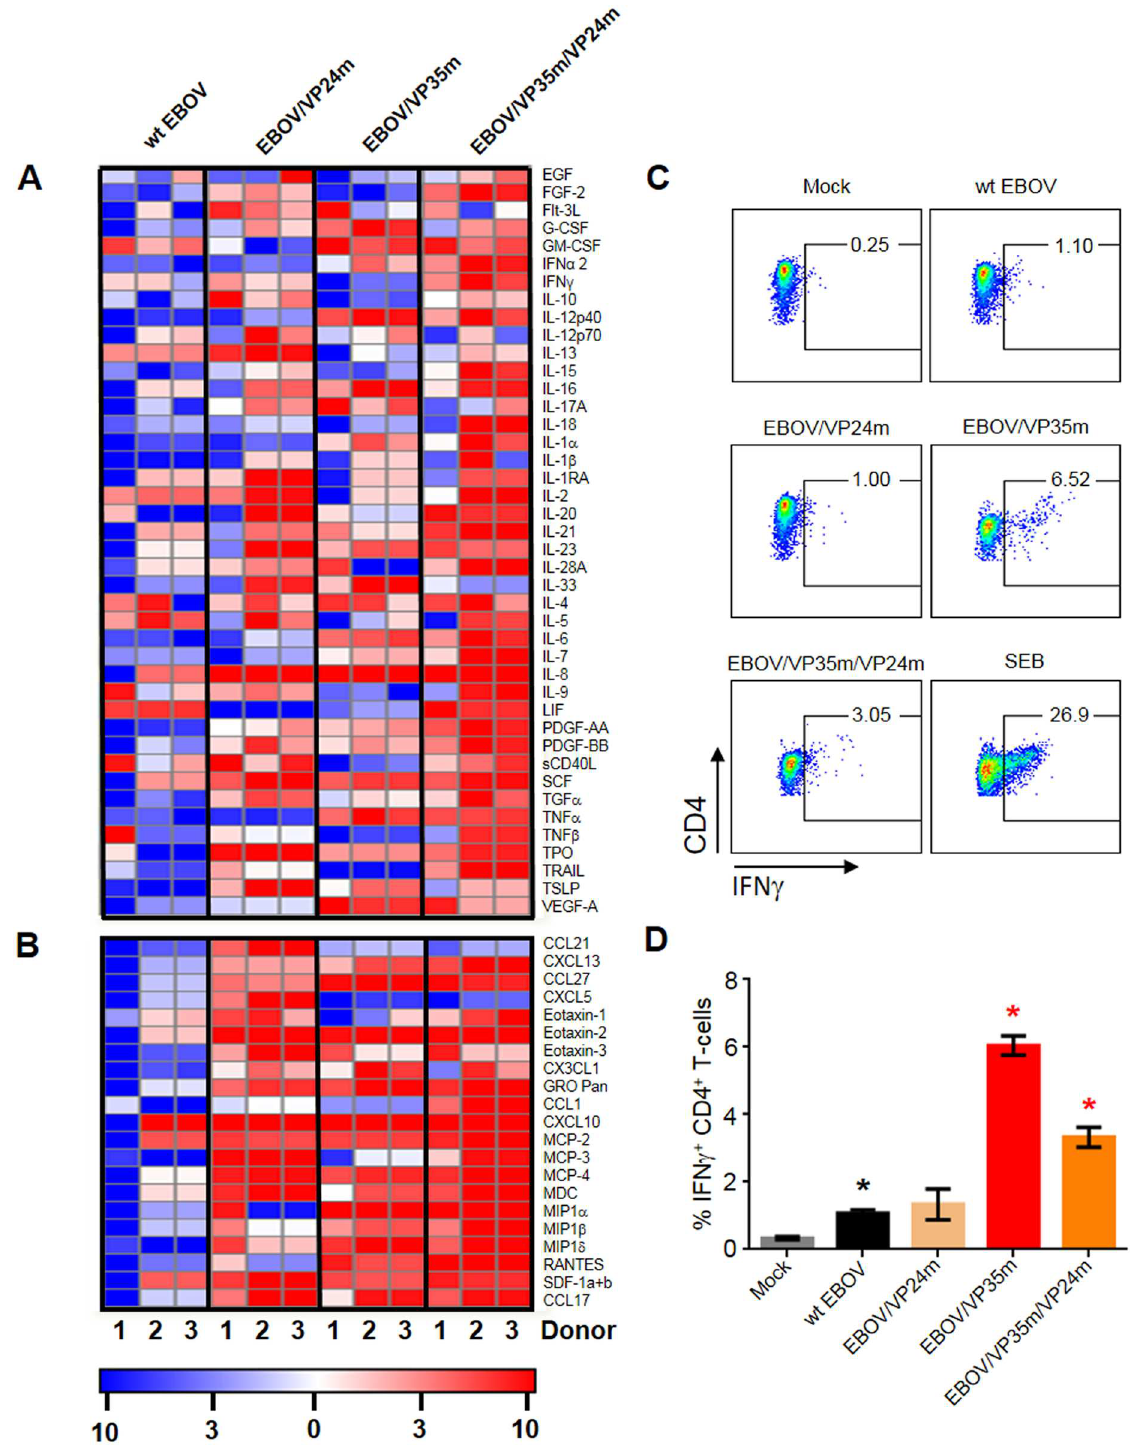
Fig 4. Disabling of IIDs changes cytokine and chemokine expressionin co-cultures of CD4 + T cells with infected DCs. A, B. CMV-pulsed, EBOV-infected DCs were co-cultured with expandedCMV-specific responder T-lymphocytes for 24 hours, and concentrations of cytokines ( A ) and chemokines( B ) in supernatantswere determined using a bead-based multiplexanalysis. Heatmap showingthe relative fold changefollowingnormalization to mock-infected samples. Results from 3 individualdonors are shown. C , D. Flow cytometry analysisof IFN γ + CD4 + T cells in DC-T cell co-cultures after transfer of conditioned media from